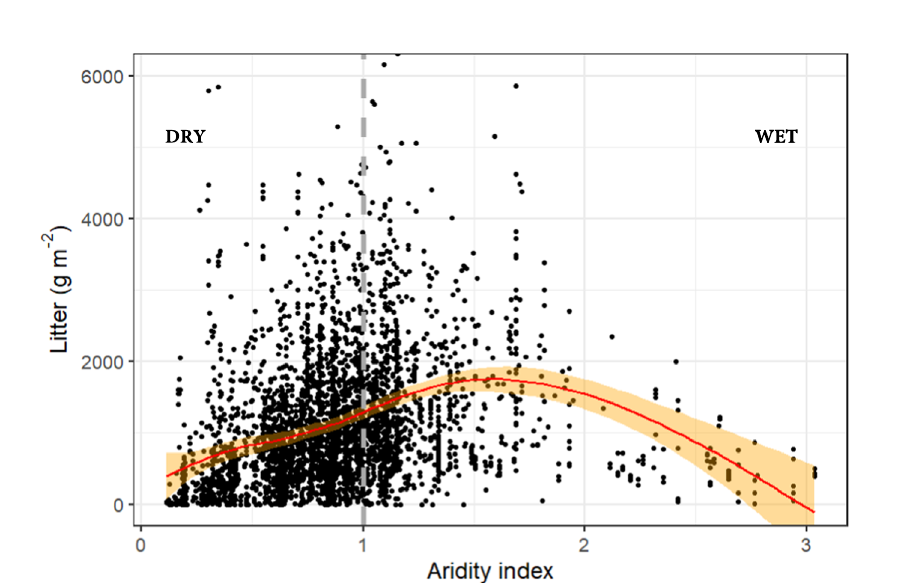
Fig. 3 | Relationship of litter mass (X Tsf ) to Aridity Index (AI) for Australian forests and woodlands. AI=1 (vertical dashed gray line) when precipitation and evapotranspiration are equal. Red line is moving average and orange shading represents the 0.999 con fi dence interval.